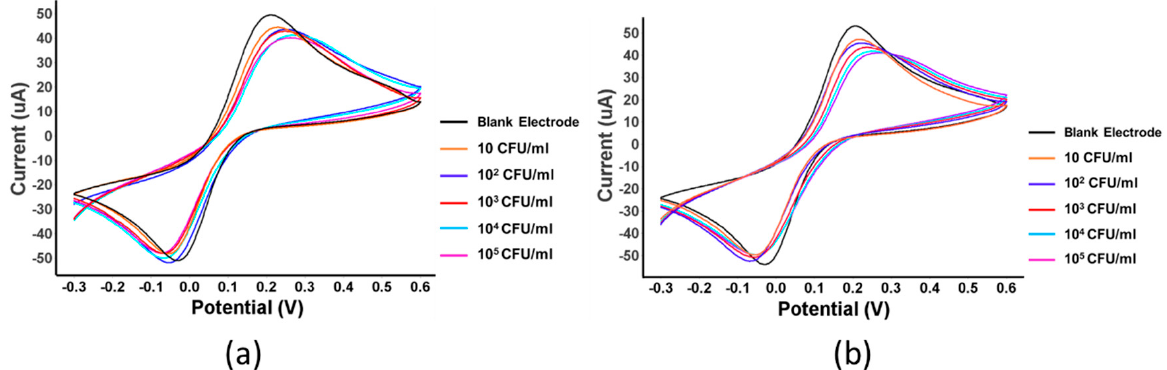
Figure 5. ( a ) Cyclic voltammogram of K. pneumoniae at concentration levels in condition 5 on gold electrode; ( b ) cyclic voltammogram of K. pneumoniae at concentration levels in condition 9 on gold electrode.